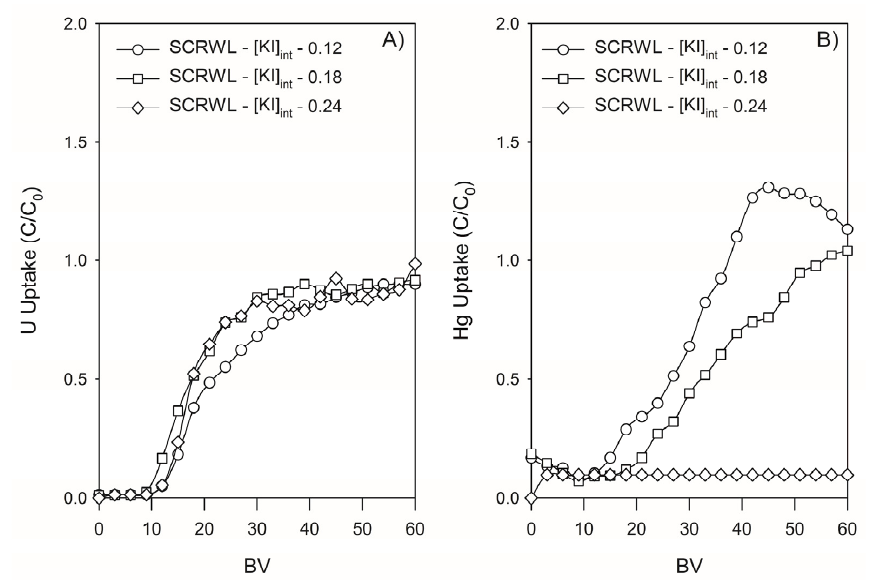
Figure 5. Chromatographic extraction profile of ( A ) uranium and ( B ) mercury on Lewatit TP260. SCRWL = KI 0.12, 0.18, 0.24 M; BV = 12 mL; Flow rate = 3 BV/h. SCRWL = KI 0.12, 0.18, 0.24 M; BV = 12 mL; Flow rate = 3